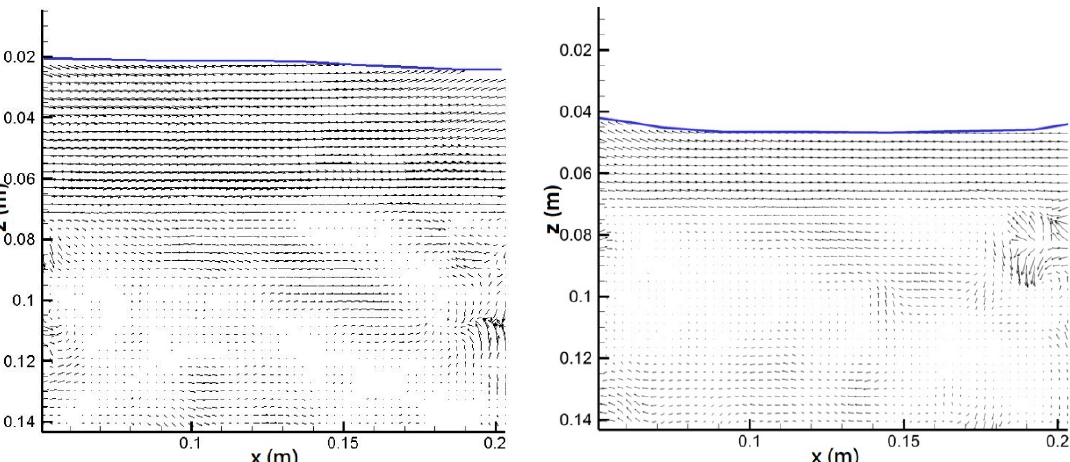
Figure 9. Velocity distribution of a long-period wave ( T = 2.0 s) around vegetation region ( ϕ = 0.5 cm and d = 10 cm).